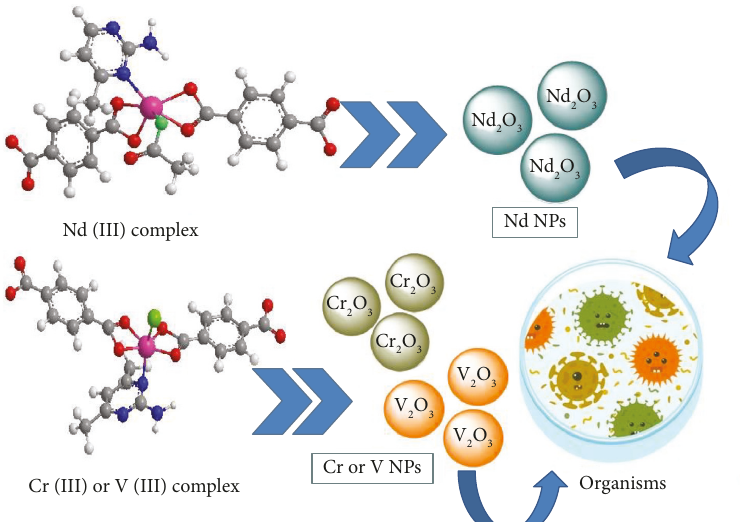
Figure 21: TEM image of V Table 8: Antimicrobial and antioxidant effect (inhibitory zone expressed in cm ± SD). Antimicrobial Compound